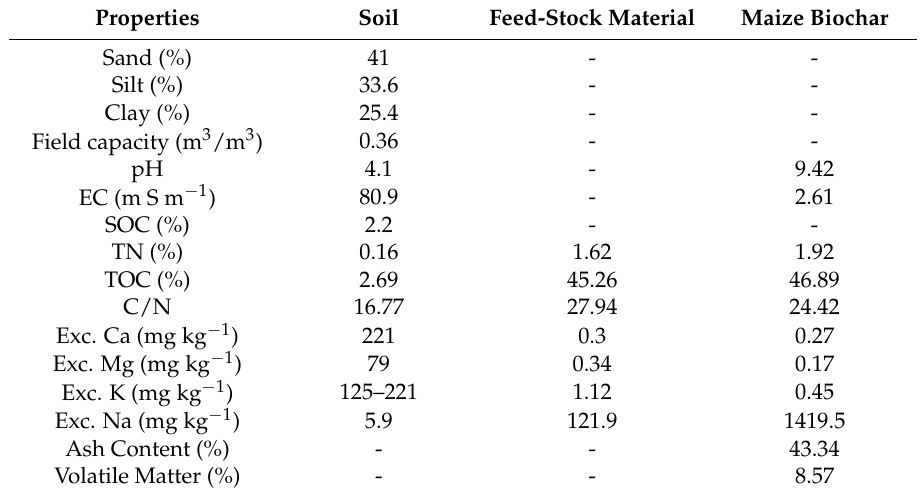
Table 2. Selected properties of the soil, biochar feed-stock (maize residue) and biochar used in the incubation study.